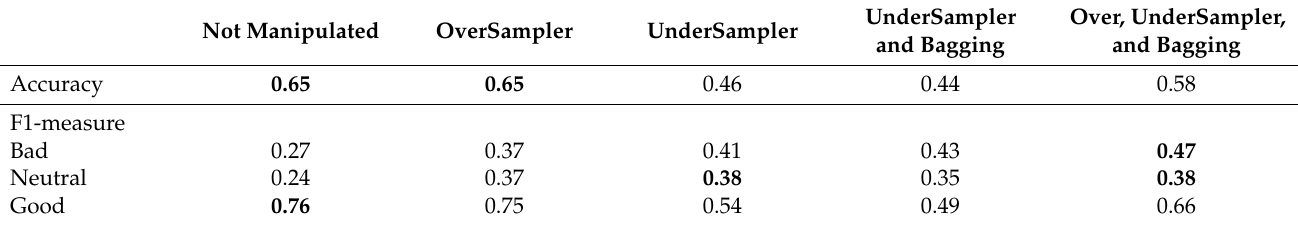
Table 6. Result of introducing SMOTE-OverSampler, RandomUnderSampler, and bagging to the previous method [26]. Estimation values are averaged over MQ and NQ.